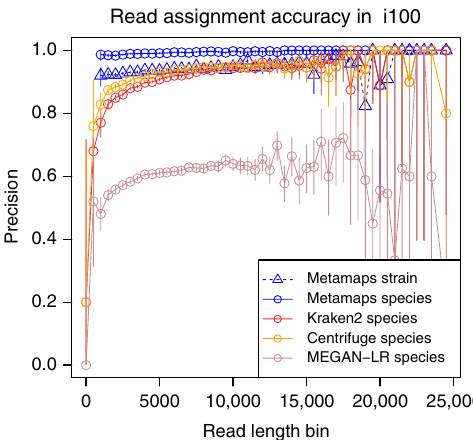
Fig. 3 Precision of called reads in simulation experiment i100, strati fi ed by read length. Note that MetaMaps results start at a minimum read length of 1000, corresponding to the “ minimum read length ” parameter the algorithm was run with. For bins above the MetaMaps minimum read length, precision equals recall. Kraken is outperformed by Kraken 2 and therefore not shown; Centrifuge stain-level accuracy is also omitted for clarity. Error bars represent 95% binomial proportion con fi dence intervals, computed using the normal